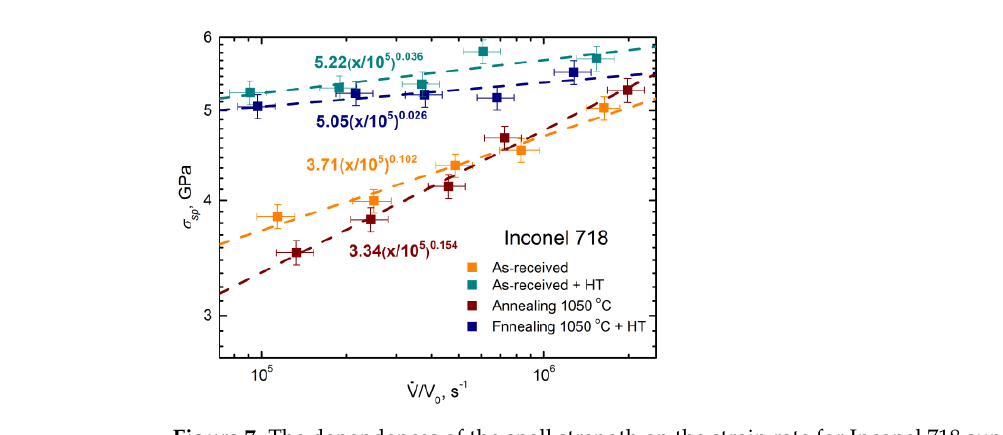
Figure 7. The dependences of the spall strength on the strain rate for Inconel 718 superalloy samples subjected to various heat treatment.